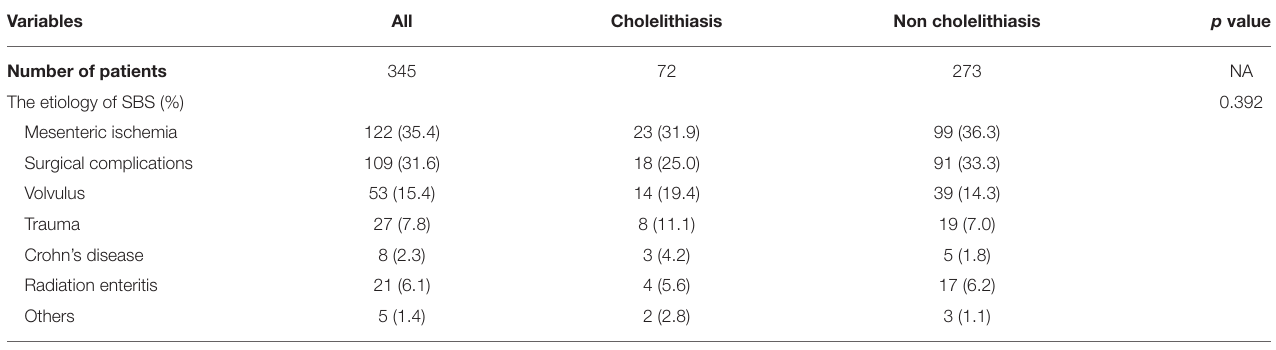
TABLE 3 | The intestinal anatomy of adult patients with SBS with and without cholelithiasis. Variables